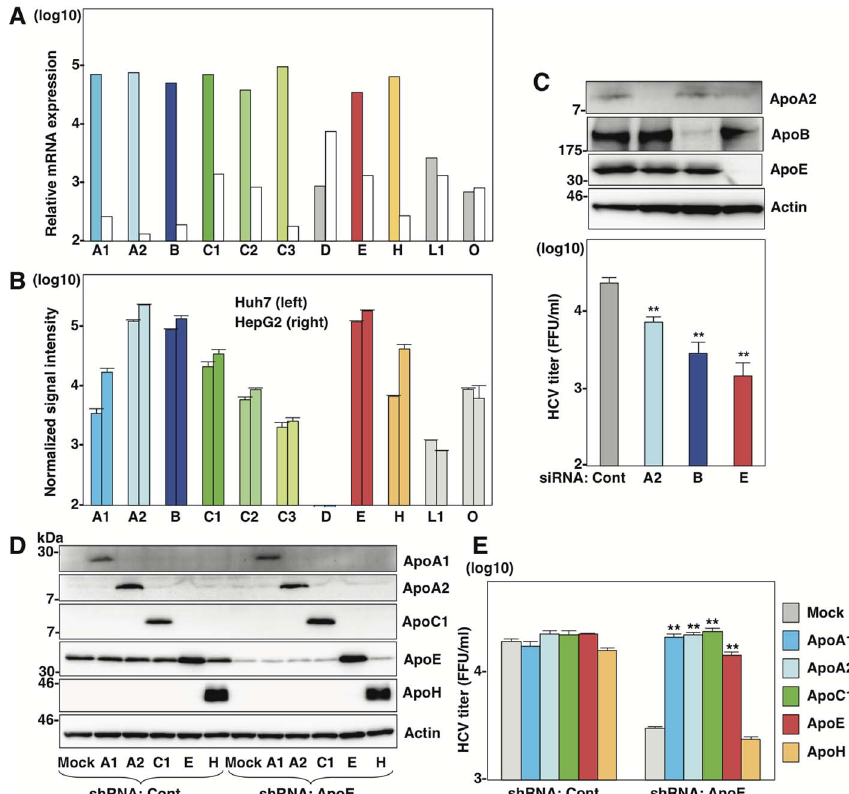
Figure 1. Several apolipoproteins participate in HCV propagation. (A) Relative mRNA expression of the apolipoproteins in the liver tissues (left columns) was determined using the NextBio Body Atlas application. The median expression (right columns) was calculated across all 128 human tissues from 1,068 arrays using the Affymetrix GeneChip Human Genome U133 Plus 2.0 Array. mRNA expression for each gene was log10 transformed. (B) Log10 transformed, normalized signal intensity of the apolipoproteins in Huh7 (left columns) and HepG2 (right columns) cells were extracted from previously published expression microarray dataset GSE32886. (C) Huh7 cells infected with HCVcc at an MOI of 1 at 6 h post- transfection with siRNAs targeting ApoA2 (A2), ApoB (B), ApoE (E) and control (Cont), and expression levels of apolipoproteins (upper panel) and infectious titers in the culture supernatants (lower panel) were determined by immunoblotting and a focus-forming assay at 72 h post-infection, respectively. (D) ApoA1, ApoA2, ApoC1, ApoE and ApoH were exogenously expressed in control and ApoE-knockdown Huh7 cells by lentiviral vectors. Expressions of the apolipoproteins were determined by immunoblotting analysis. (E) Infectious titers in the culture supernatants of control and ApoE-knockdown Huh7 cells expressing the apolipoproteins were determined by focus-forming assay at 72 h post-infection. In all cases, asterisks indicate significant differences (*, P , 0.05; **, P , 0.01) versus the results for control cells.